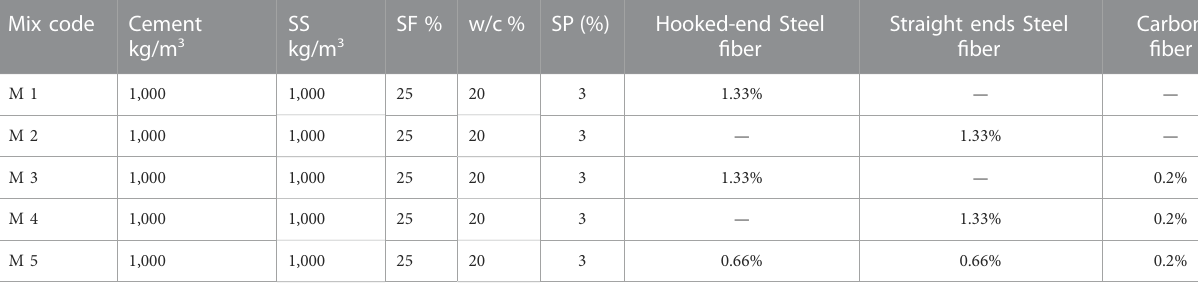
TABLE 4 Mix proportions for the 5 UHPC